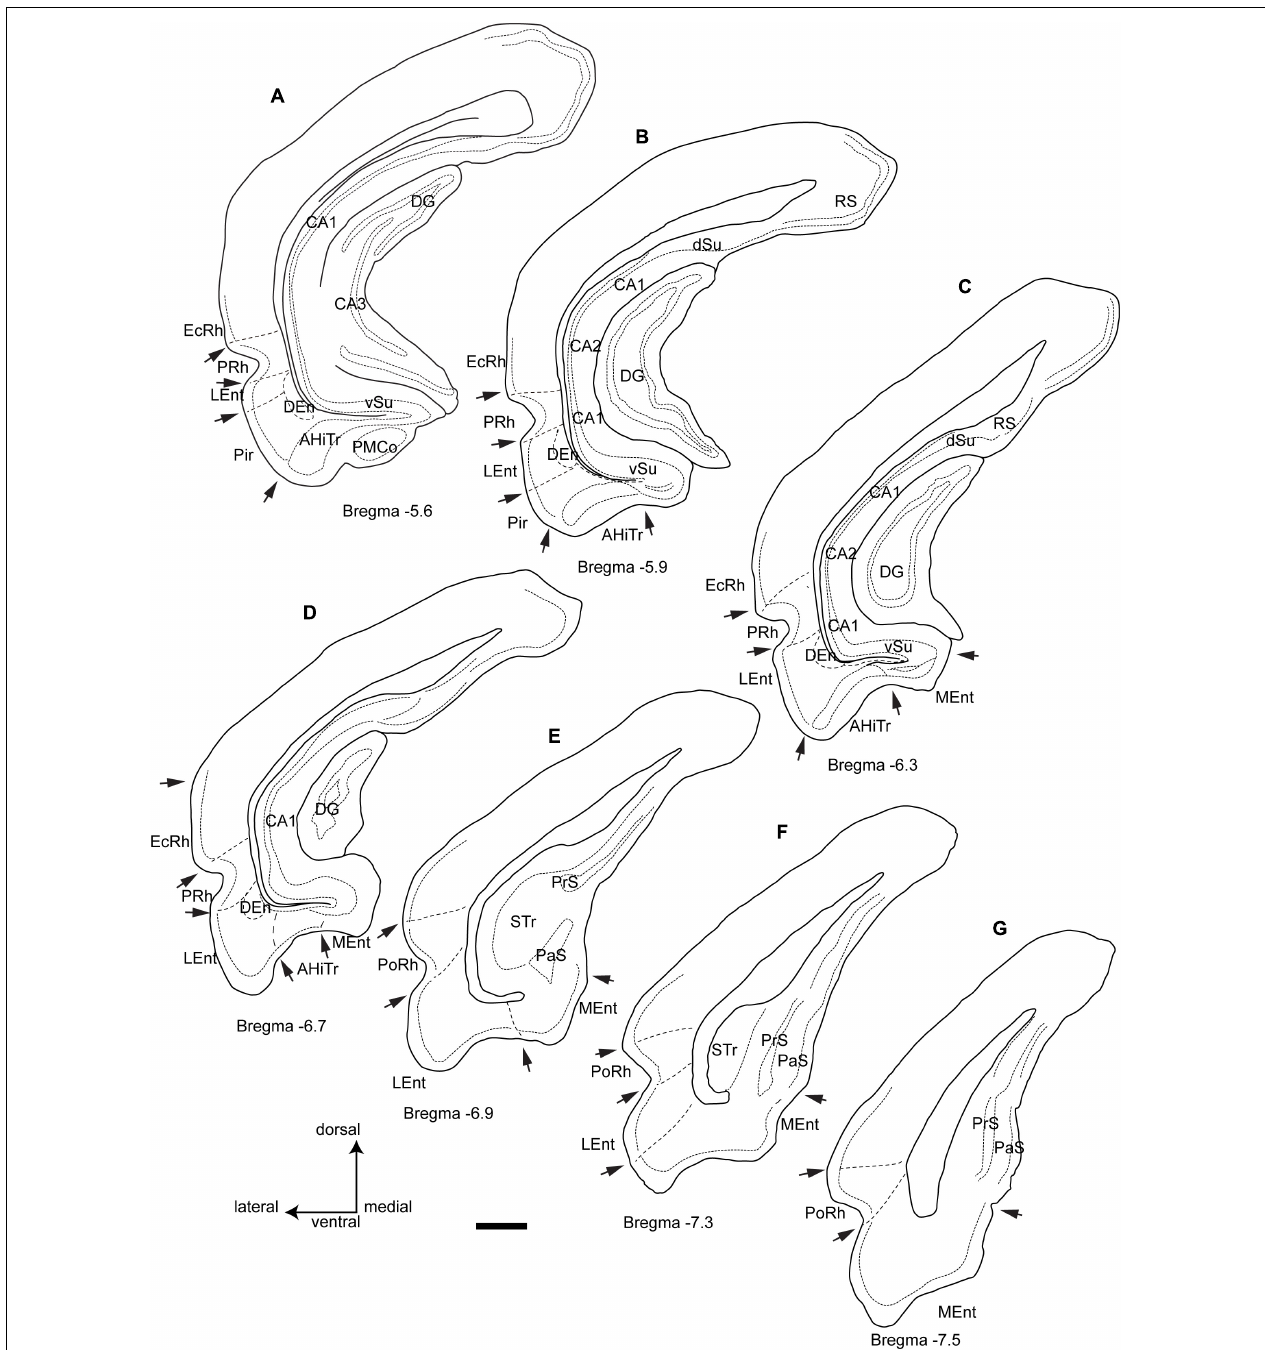
FIGURE 1 | Camera lucida drawings of the rostrocaudal extent of the parahippocampal cortex and the main divisions and landmarks used in this study of the distribution of fibers within cytoarchitectonic defined divisions from rostral level A (Bregma − 5.6) to the caudal level G (Bregma − 7.5). Arrows point at boundary landmarks between consecutive areas. Calibration bar 1